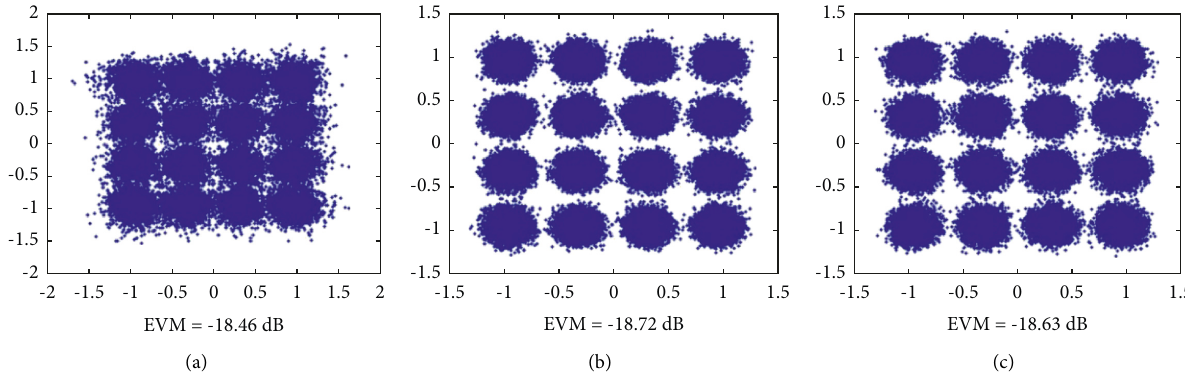
Figure 9: Constellation diagrams of the recovered 16QAM and their EVM values. (IFFT � 1024, I Bias � 100mA). (a) Conventional (b) FDS- precoding (c)